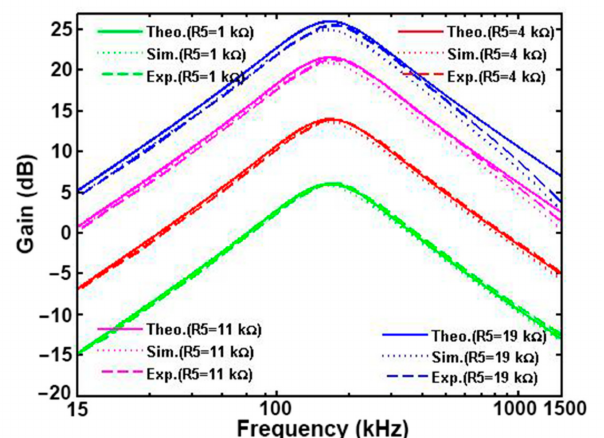
Figure 28. The theoretical, simulated and measured NBPF responses at the voltage output of V BP6 when R 5 was varied.